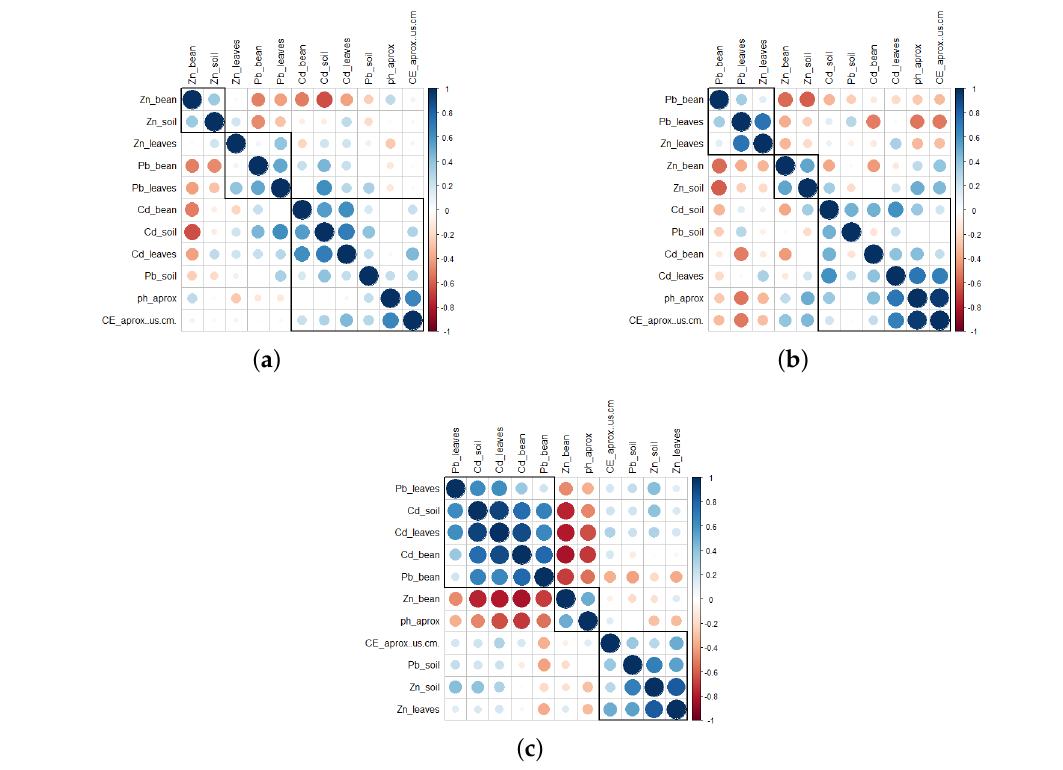
Figure 5. Correlation of heavy metals in soil, bean and leaves ( a ) The entire farm; ( b ) CCN51; ( c ) Creole-aromatic